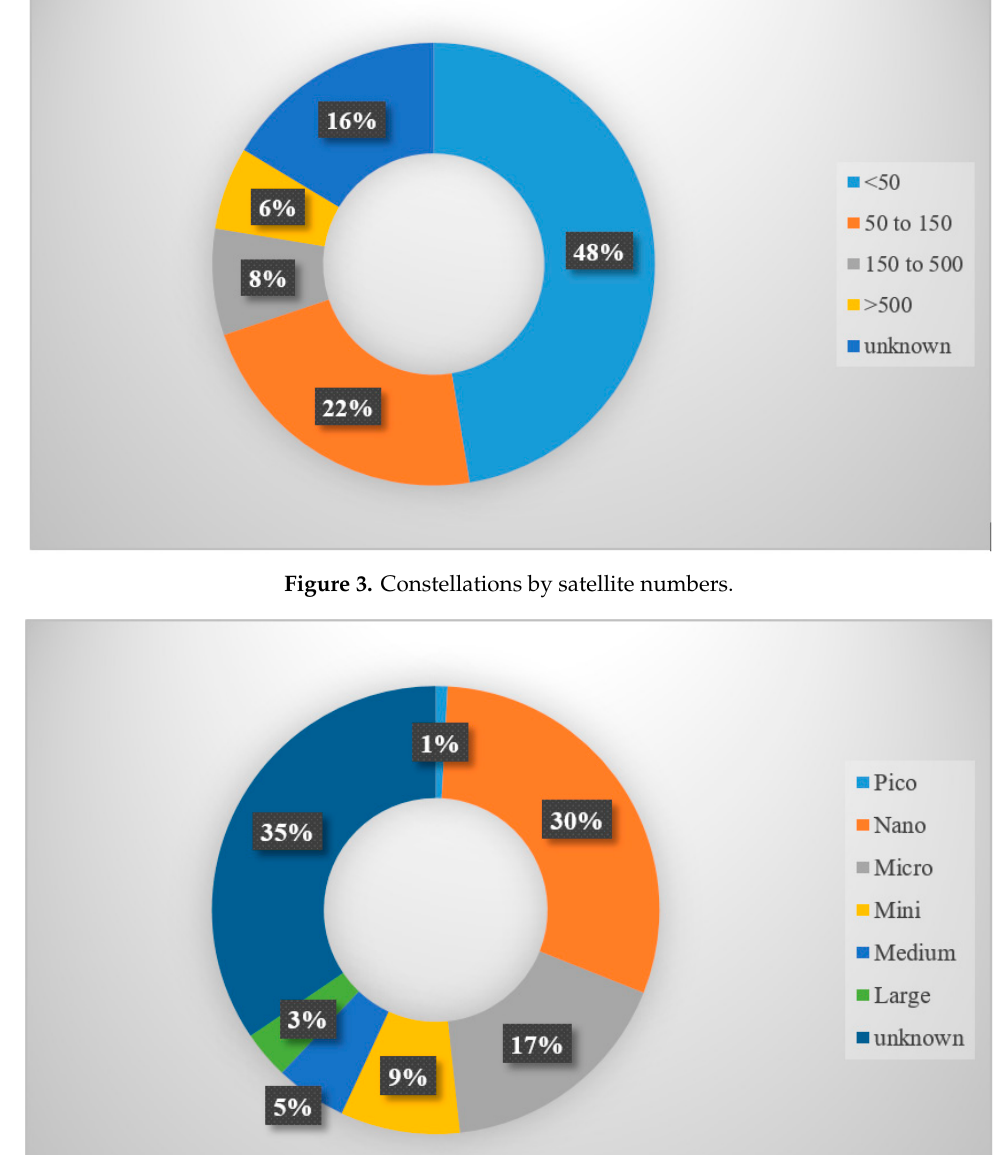
Figure 2. Expected time evolution of in orbit spacecraft due to constellations. Colored histogram bars represent the estimated number of satellites launched yearly (see Table A1 in Appendix for details). Black, dotted line represents cumulative sum. Not-classified (NC) stands for companies that have not published expected time-to-service.